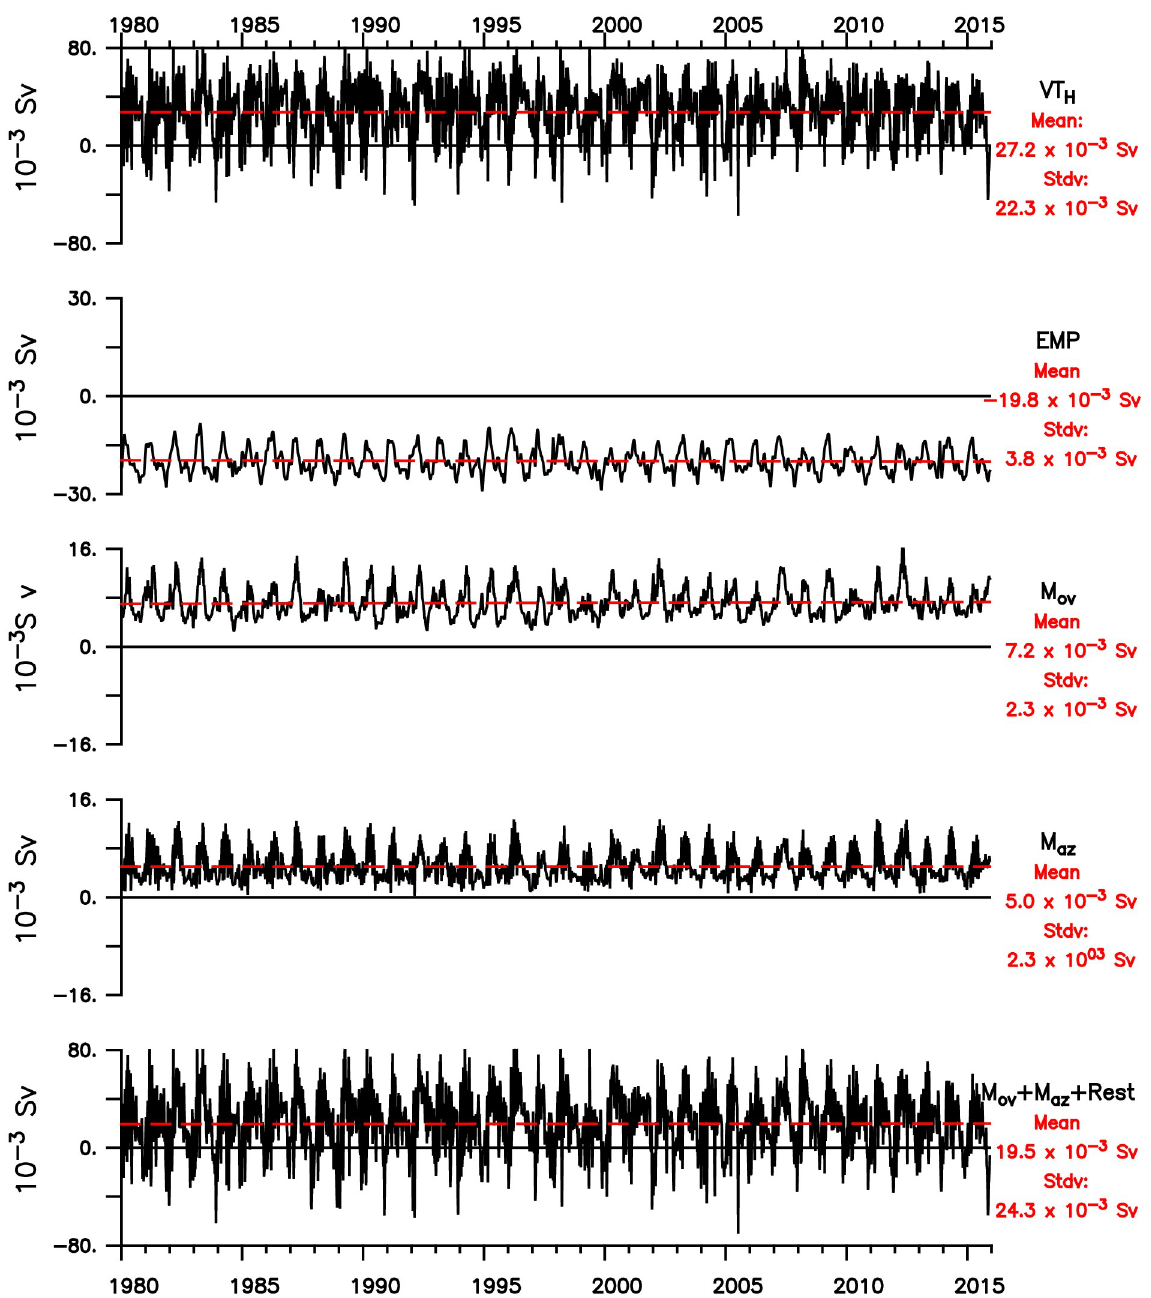
Fig 10. From top to bottom: Time series of the total volume of water transported across the Hormuz section ( VT precipitation over the Gulf ( EMP ), the overturning and horizontal components of the freshwater transport by the baroclinic circulation across Hormuz ( M and M ) and thesum of M , M and the residual term R ov az ov az